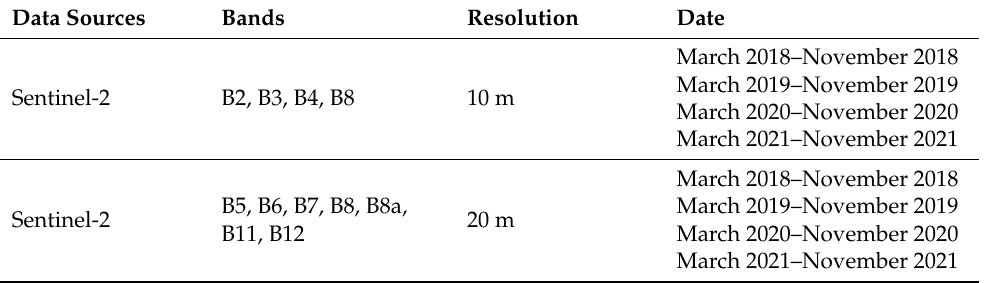
Table 1. The geospatial data sources from the Sentinel-2 satellites.